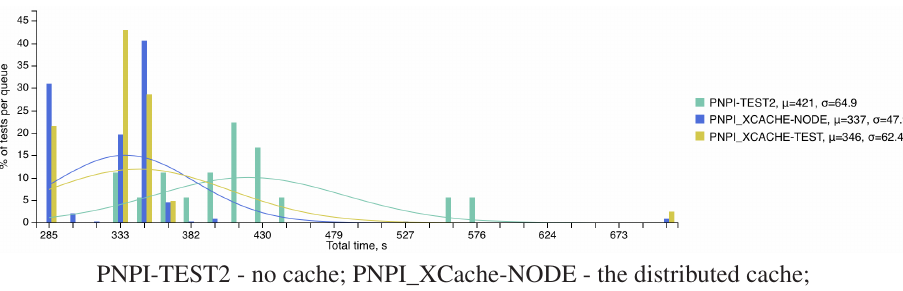
Figure 4. The monitoring web application interface